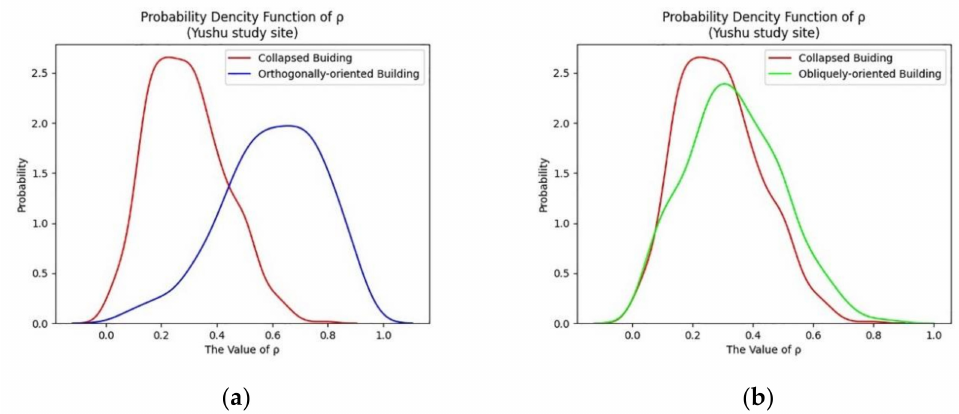
Figure 15. The pdfs of the circular polarization correlation coefficient ( ρ ) feature: ( a ) pdfs of collapsed buildings and orthogonally-oriented buildings; ( b ) pdfs of collapsed buildings and obliquely-oriented buildings.